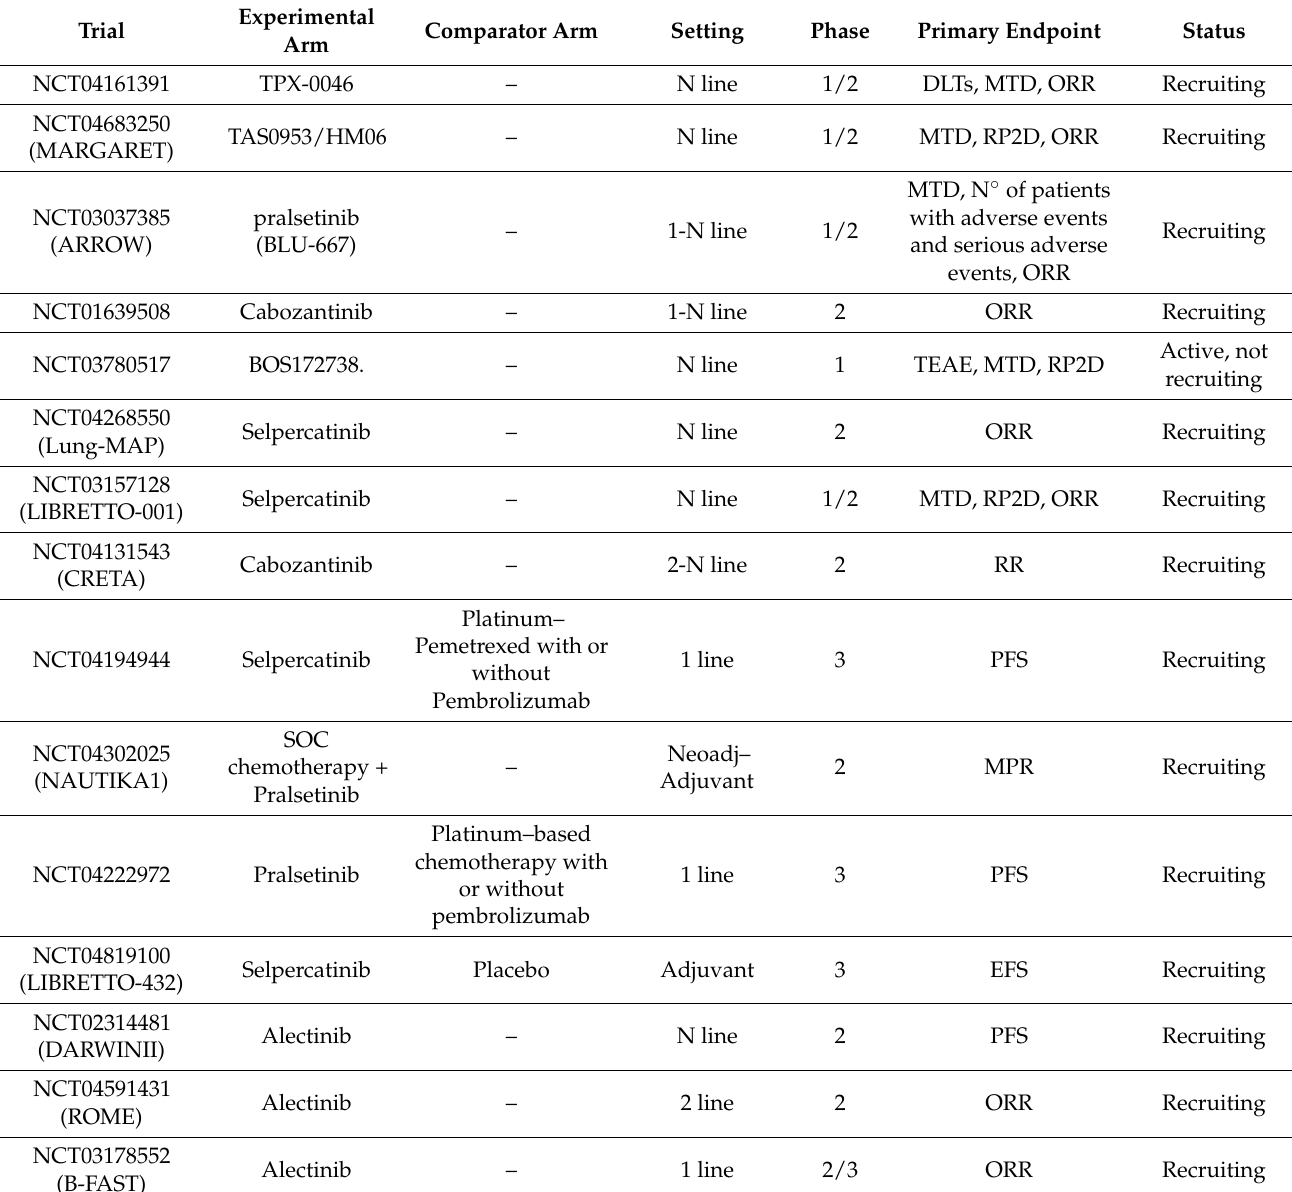
Table 3. Ongoing Clinical Trials Investigating RET-TKIs in RET Fusion Positive